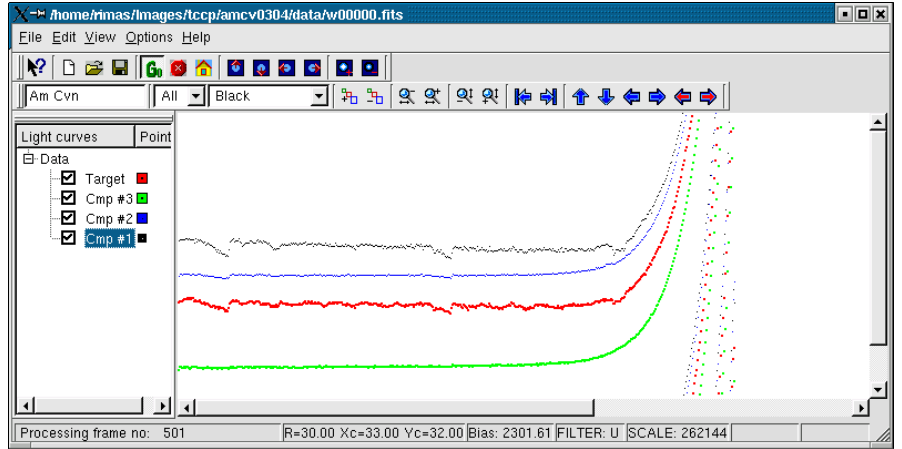
Fig. 3. The main window of RTP program with data